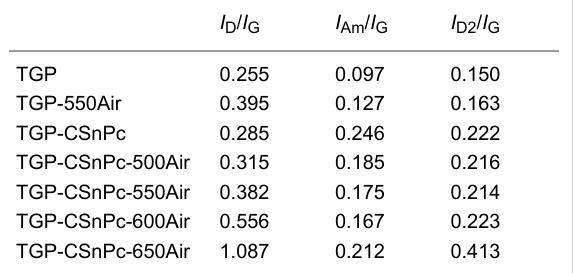
Table 2: Ratio between the intensity of the D, Am, and D2 peaks and that of the G peak.